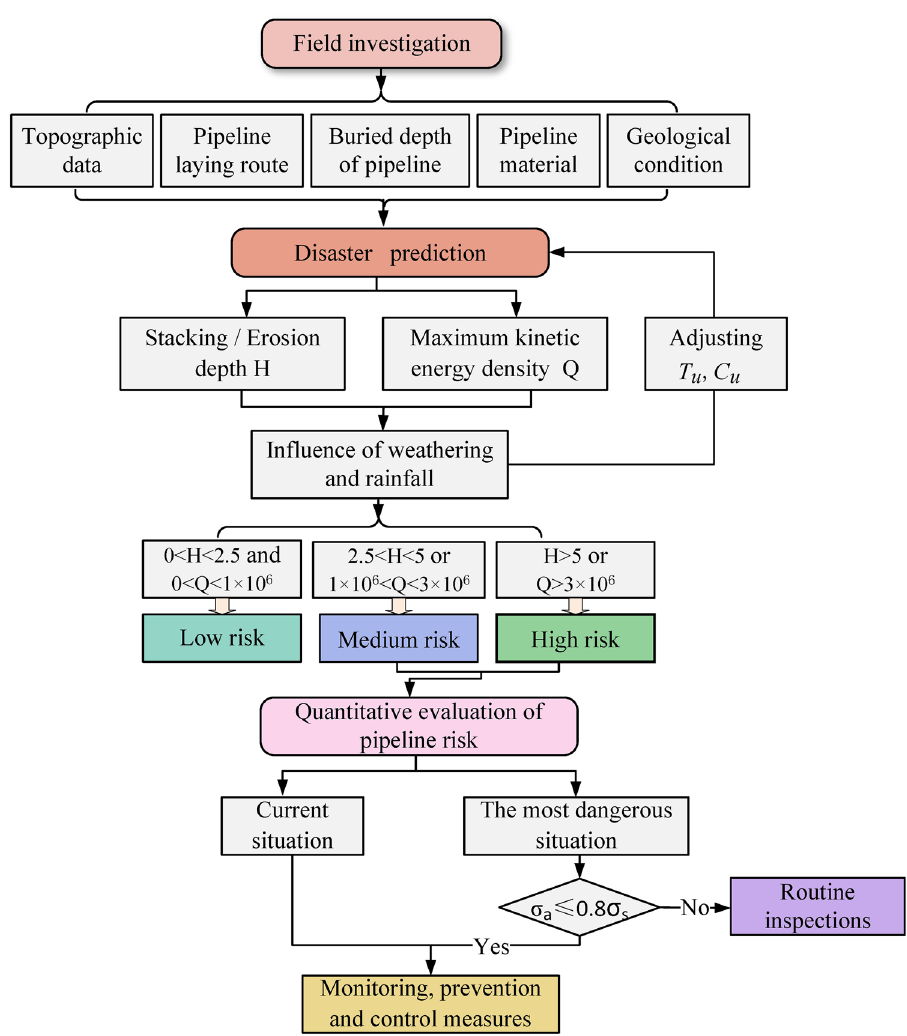
Fig. 3 Flowchart showing the method for the quantitative pre- diction of pipeline slope disaster risk developed in this study; T u is the uniaxial tensile strength, C u is the uniaxial compressive strength, 𝜎 a is the pipe stress, and 𝜎 s is the minimum yield